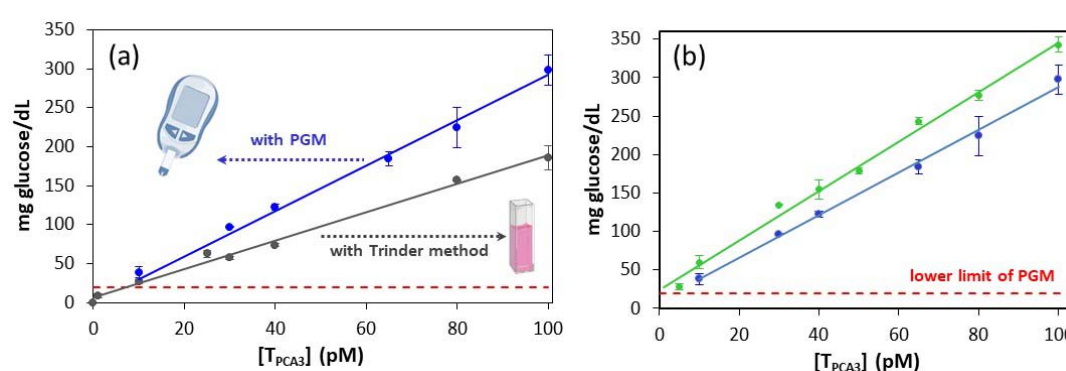
Figure 4. Calibration plots constructed for the determination of T PCA3 . ( a ) One signaling probe grey: using colorimetric (Trinder method) and blue: using electrochemical (PGM) detection. ( b ) PGM readout: in green, two signaling probes; in blue, one signaling probe. Error bars were obtained through the detection of two parallel samples on two di ff erent days (four replicates in total). Equations of the calibration curves obtained in each case are presented in Table S1. Notice that the slope of the calibration curve obtained with the PGM-based method is significantly higher than that with Trinder method, thus resulting in a more sensitive